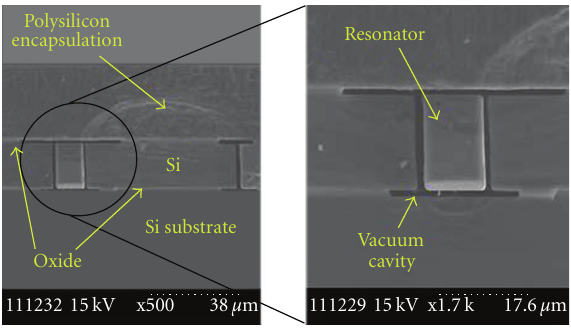
Figure 22: Example of an MEMS resonator